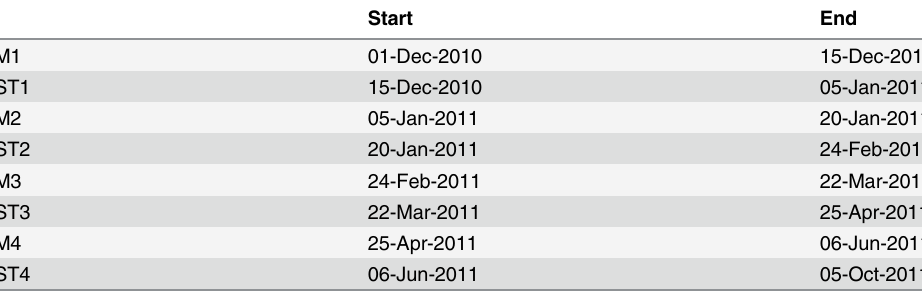
Table 1. Dates of mixing events and stability